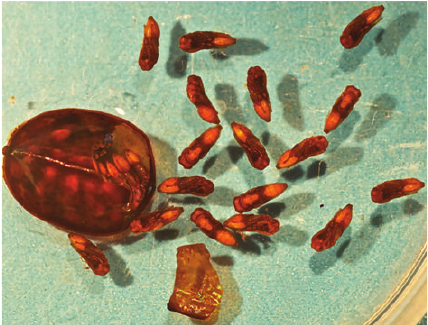
Figure 1: Empty puparium from which an adult microdontine fly has emerged, as found included with silk in the nest walls of its host Camponotus sp. aff. textor . Photo: J.-P. Lachaud and G. P´erez- Lachaud.